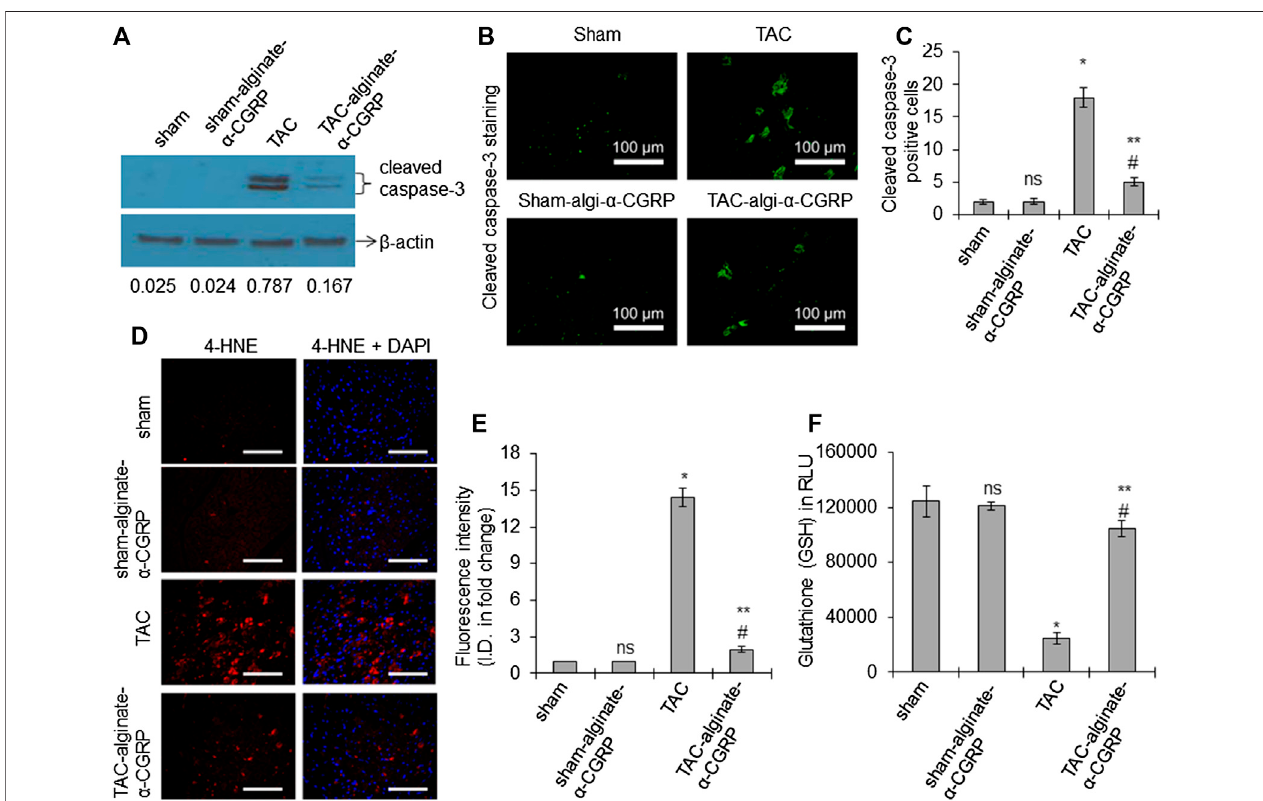
FIGURE5| Alginate- α -CGRPmicrocapsulesdeliveryintwo-day post-TAC mice attenuates increasedLVapoptosis and oxidative stressinTAC mice. (A) Western blot showing the level of cleaved caspase-3 protein in LVs from sham, sham-alginate- α -CGRP, TAC, and TAC-alginate- α -CGRP. β -actin was used as control. The density of the protein bands were quantitated by NIH-ImageJ and cleaved caspase-3/ β -actin band density ratio was reported. (B) Representative fl uorescence images showing cleaved caspase-3 staining (green) to detect apoptosis in the LV sections. Scale (cid:1) 100 μ m. Cleaved caspase-3 positive cells (green) were counted and plotted as the mean ± SEM (C) . (D,E) Fluorescence images showing 4-HNE staining (a marker of lipid peroxidation) in the paraf fi n-embedded LV sections. DAPI was used to stain nuclei. Scale (cid:1) 100 μ m. The fl uorescence intensity of 4-HNE (red) was quantitated by the NIH-ImageJ software and plotted as the mean ± SEM. I.D. (cid:1) integrated density. (F) Bar diagrams showing glutathione (GSH) level in the LVs. Values were expressed as the mean ± SEM and p < 0.05 was considered signi fi cant. * p < 0.05, TAC vs sham; ** p < 0.05, TAC-alginate- α -CGRP vs TAC; # p > 0.05, TAC-alginate- α -CGRP vs sham; ns (cid:1) not-signi fi cant compared to sham.